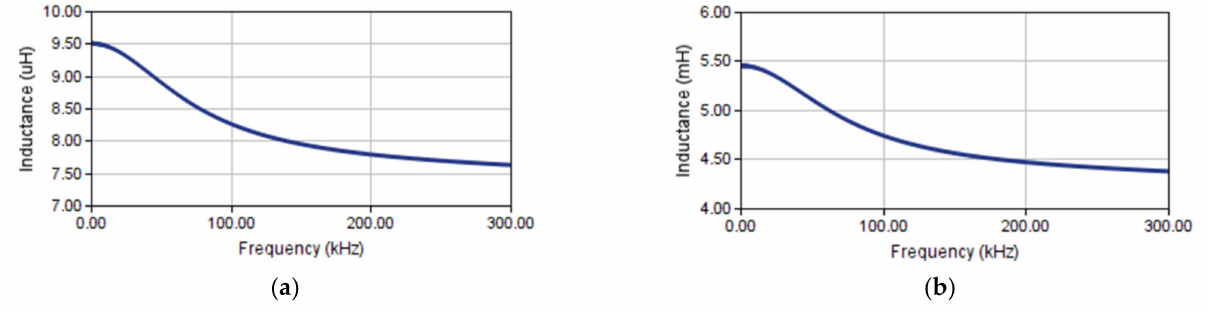
Figure 18. Leakage inductance of toroidal transformer ( N p = 24 & N s = 600). ( a ) Primary winding, ( b ) Secondary winding.